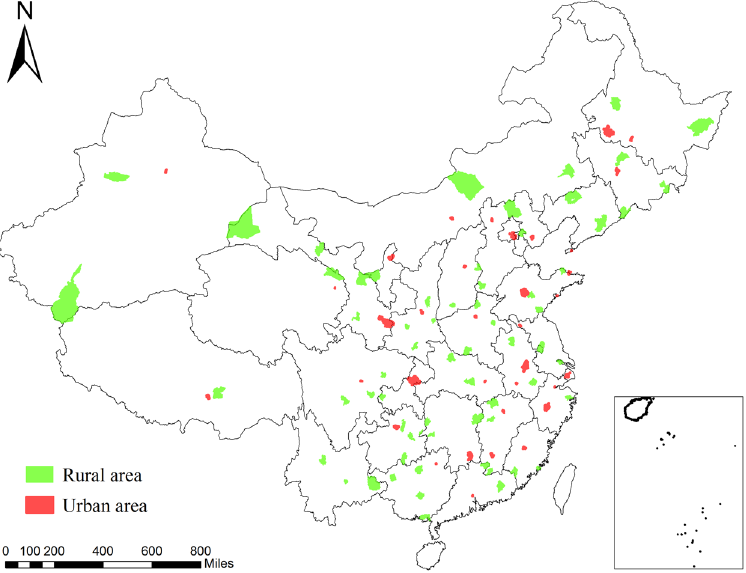
Figure 4. Locations of the 103 continuous disease surveillance points by urban and rural status in China. This map was generated by ArcGIS software, version 10.2